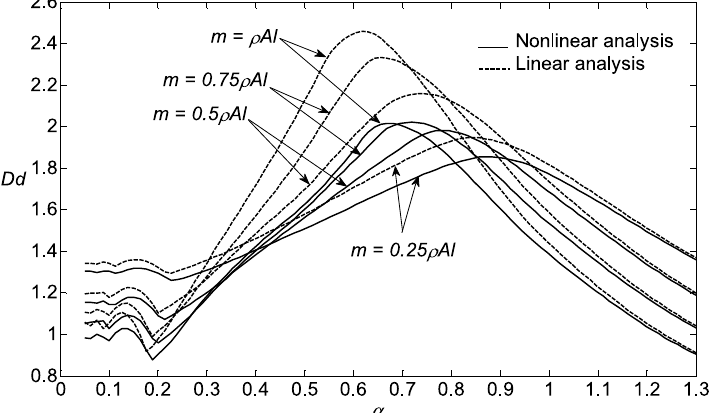
Fig. 3. Variation of dynamic magni fi cation factor ( D d ) vs. α for an inclined self-weight Timoshenko beam with θ = 36 ◦ affected by a moving mass of m (kg). (—–) nonlinear analysis, ( ) linear